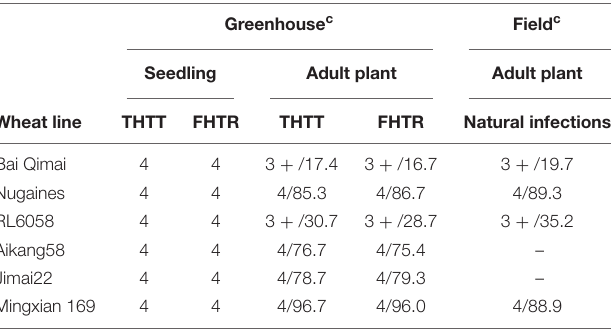
TABLE 1 | Infection type (IT) a and disease severity (%) b of the parental wheat lines and check under greenhouse conditions and in the fields.